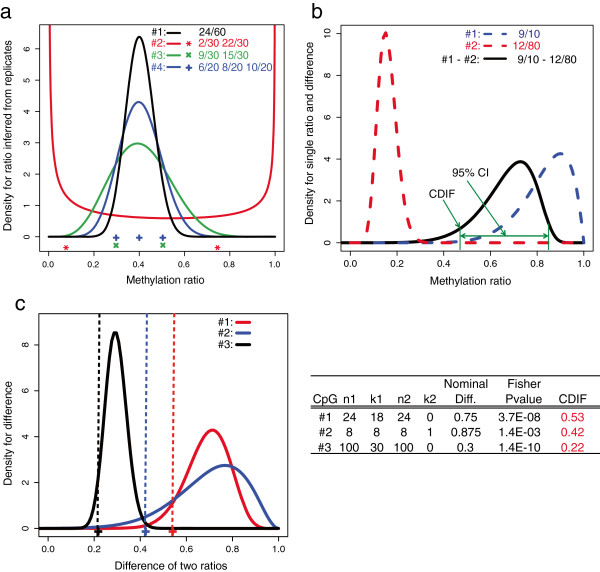
Overview of the MOABS algorithm. (a) Posterior distribution of methylation ratio inferred from biological replicates. Each curve represents the inferred methylation ratio Beta distribution of a CpG. The symbols at the bottom indicate the observed methylation ratios of all replicates. The values on the top right corner indicate number of methylated reads over number of total reads in each replicate. (b) An example of Credible Methylation Difference (CDIF). Dash curves indicate inferred methylation ratio Beta distributions from low (Sample #1) or high sequencing depth (Sample #2). The black curve is the exact distribution of the methylation difference between two samples. The CDIF is shown as the lower bound of the 95% confidence interval. (c) Ranking of three CpG examples by CDIF, FETP p-value and nominal difference, i.e. direct subtraction of two methylation ratios. The three curves are the exact distributions of methylation differences. The corresponding CDIF values are show as vertical dash lines.